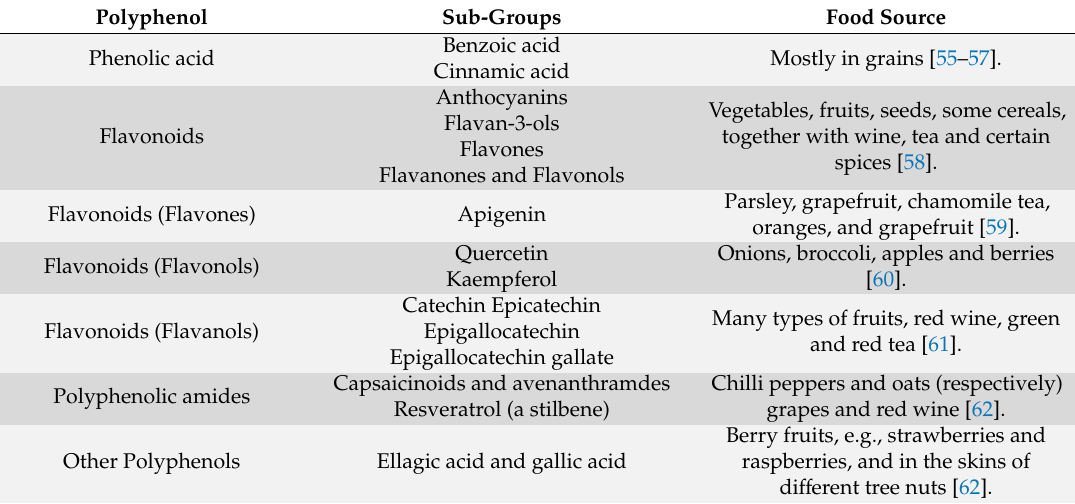
Table 1. Classification of polyphenols commonly found in a Mediterranean-style